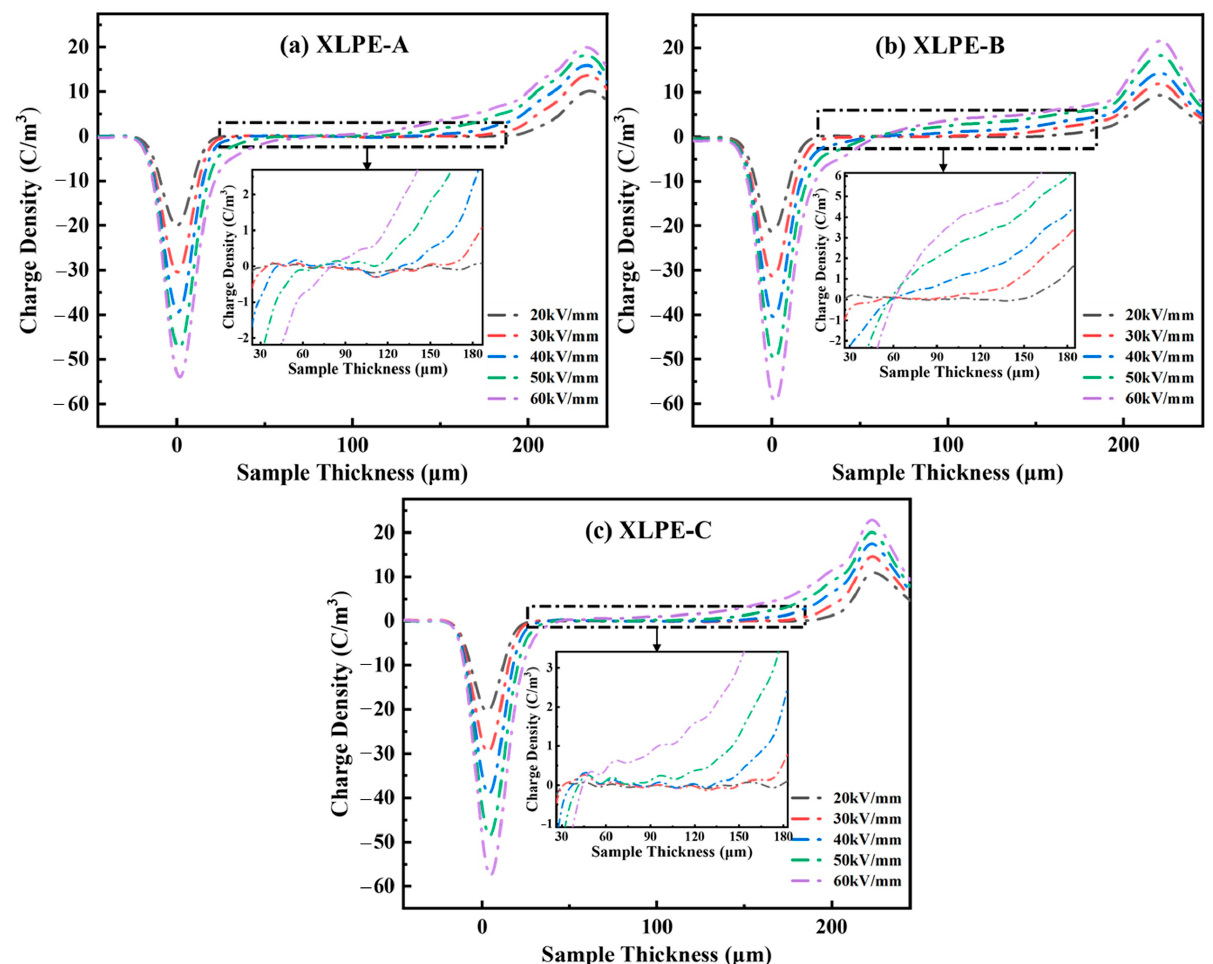
Figure 12. Space charge accumulation at 30 °C under 20–60 kV/mm stress conditions through pulsed-electro acquisition (PEA) technique for XLPE prepared with appropriate content of DCP. The insets shown in this figure illustrates the space charge accumulation between the sample thickness of 30 µm to 180 µm for XLPE prepared with appropriate DCP contents. ( a ) Space charge accumulation for XLPE-A developed with 1.4% DCP. ( b ) Space charge accumulation for XLPE-B developed with 1.7% DCP. ( c ) Space charge accumulation for XLPE-C with 2% DCP.